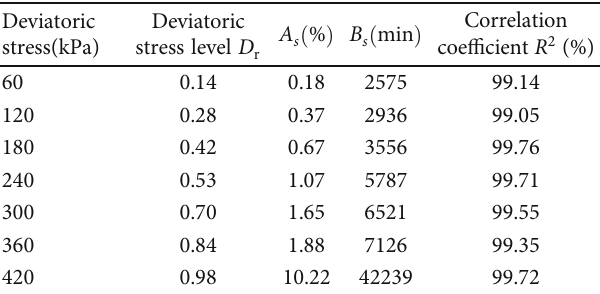
Figure 16: Fitting curves of e ff ective stress creep curve of intact soil. Table 7: Hyperbolic model parameters(kPa) and correlation coe ffi cient R 2 of the triaxial creep test (intact clay).